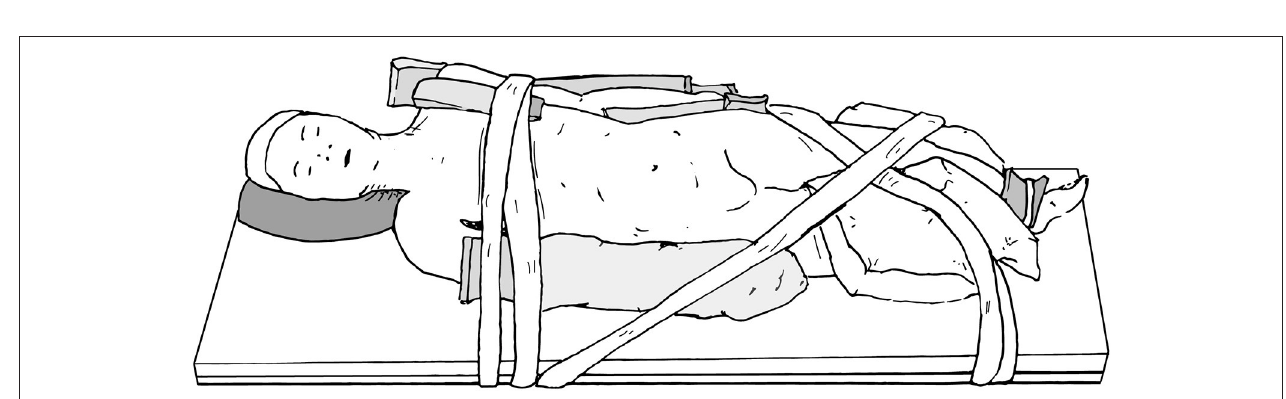
FIGURE 5 | Modified flank positioning used for upper tract surgery, with proper padding, and tape securing the patient to the operating table.